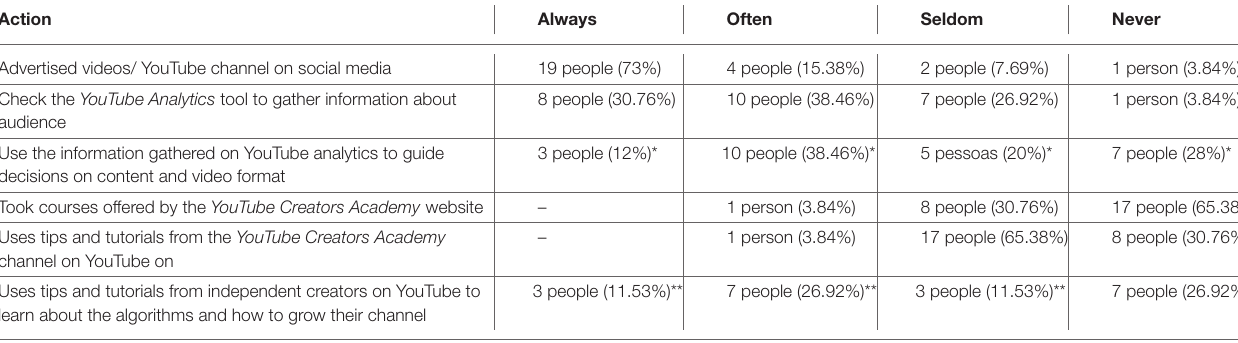
TABLE 3 | Strategies and sources of knowledge used by science communicators to comprehend and navigate YouTube.